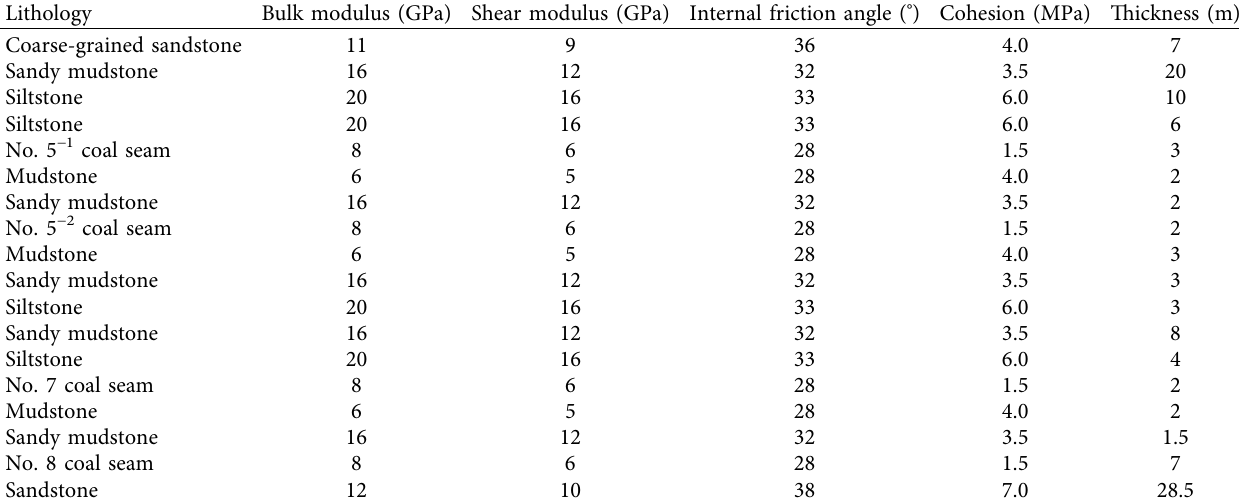
Table 3: Physical mechanical parameters of the rock